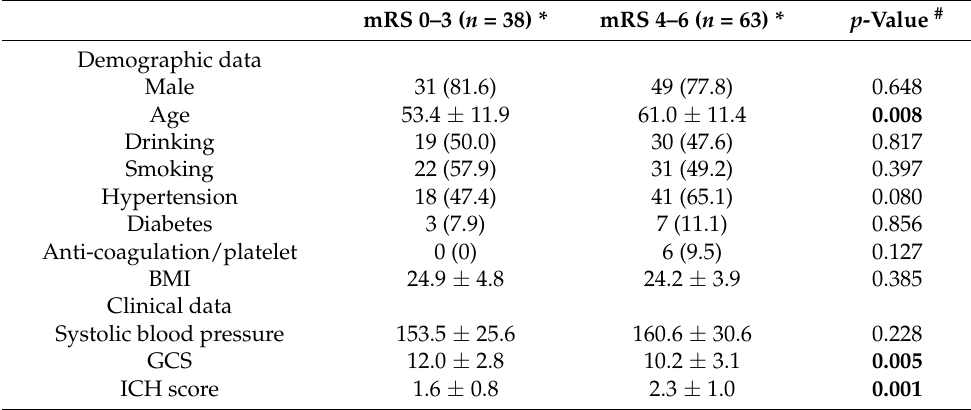
Table 2. Univariate analysis of poor outcome 3 months after